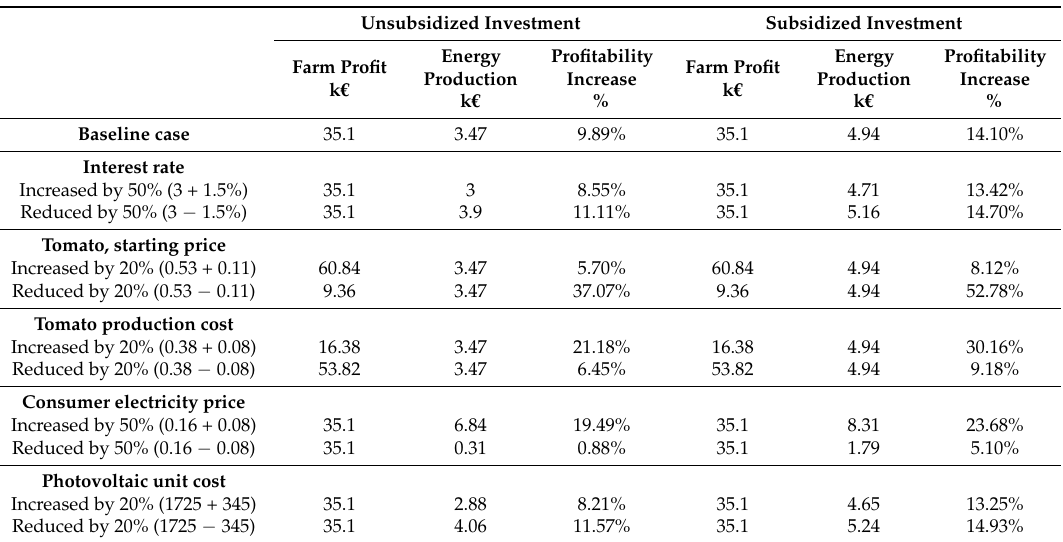
Table 2. Sensitivity analysis (1.8